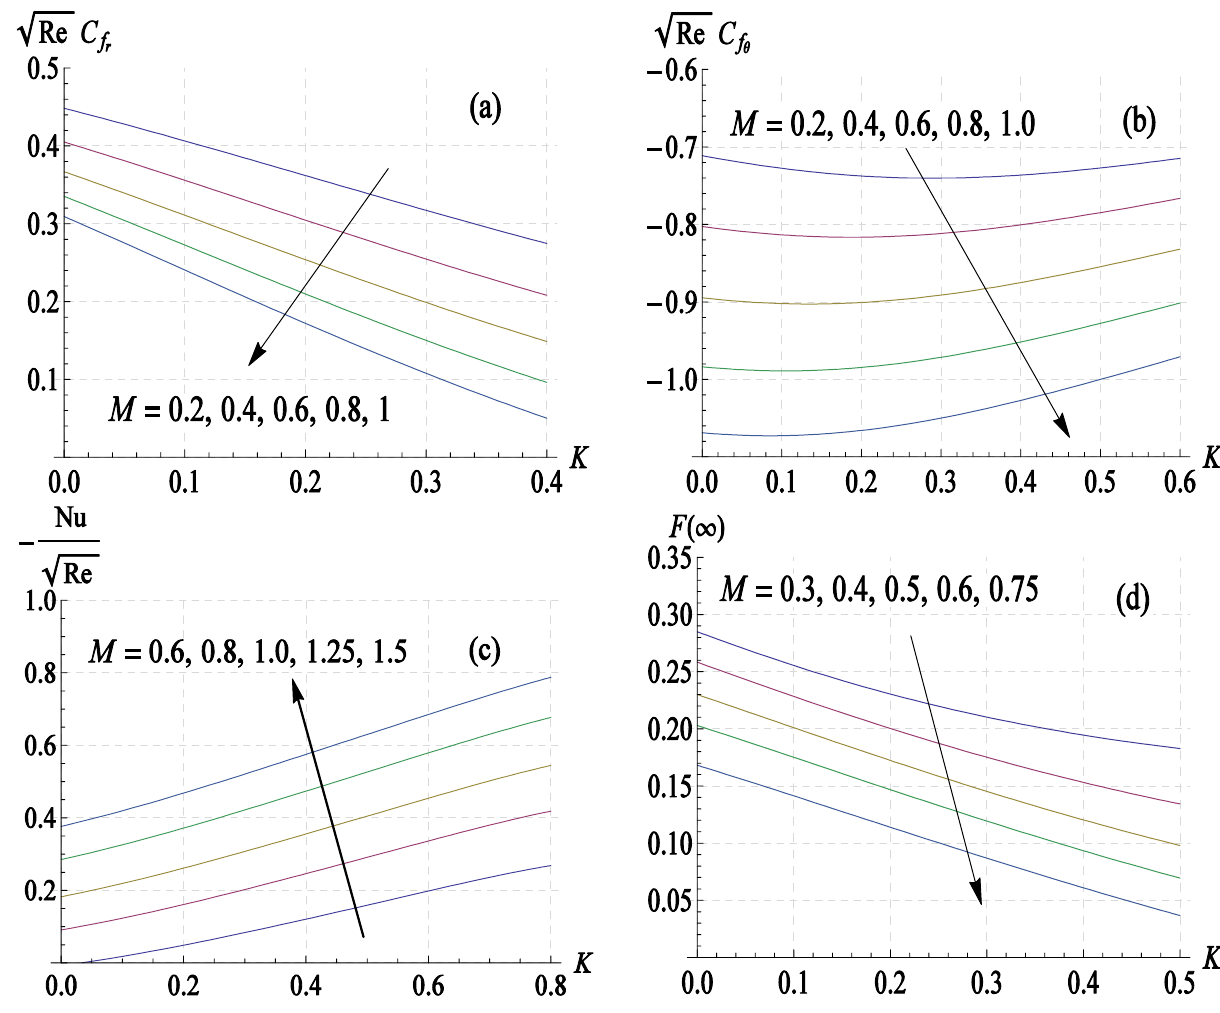
Figure 6. Profiles of skin friction coefficients, Nusselt number and volume flow rate versus elasticity parameter K at different values of M